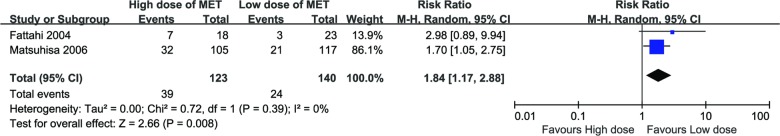
Forest plot of high-dose therapies vs. low dose-dose therapies in total side effects.